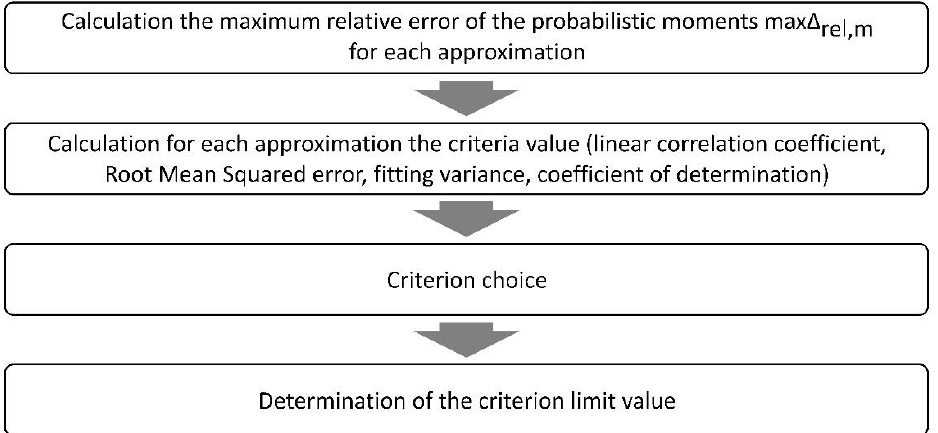
Figure 7. Comparison of the approximation accuracy criteria for all the groups of functions, its various base POb and the number of significant digits of rounding D1 : ( a ) the maximum relative error of the base polynomial coefficients Δ rel,c , ( b ) the maximum relative error of the probabilistic moments max Δ rel,m for α max *( x ) = 0.30.